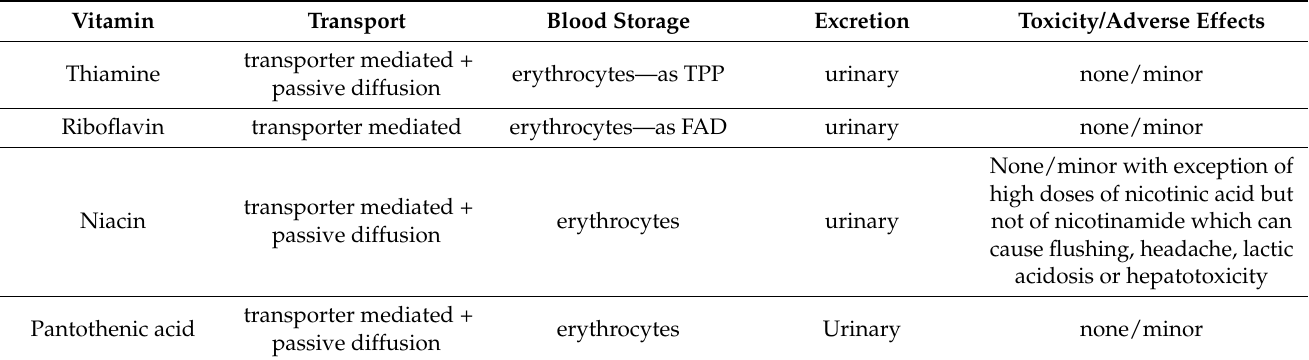
Table 12. Selected common biological properties of described